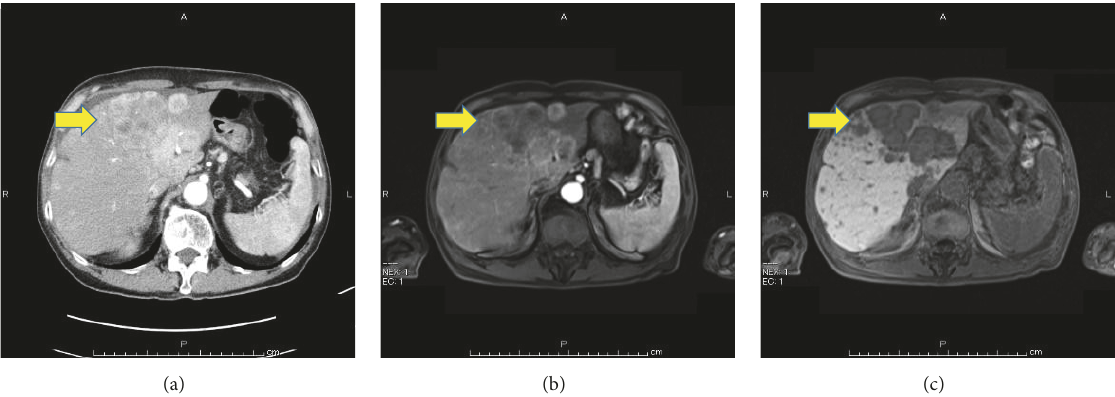
Figure1:Dynamiccontrast-enhancedcomputedtomography(CT)scansshowedmultiplemassesinthepatient’sliver,suggestingintrahepatic cholangiocarcinoma (ICC; (a), arrow). His liver tumors showed an enhancement of the peripheral zone in the early phase ((b), arrow) and a low intake in the hepatobiliary phase ((c), arrow) in a gadolinium ethoxybenzyl diethylenetriamine pentaacetic acid- (Gd-EOB-DTPA-) enhanced magnetic resonance imaging (MRI).